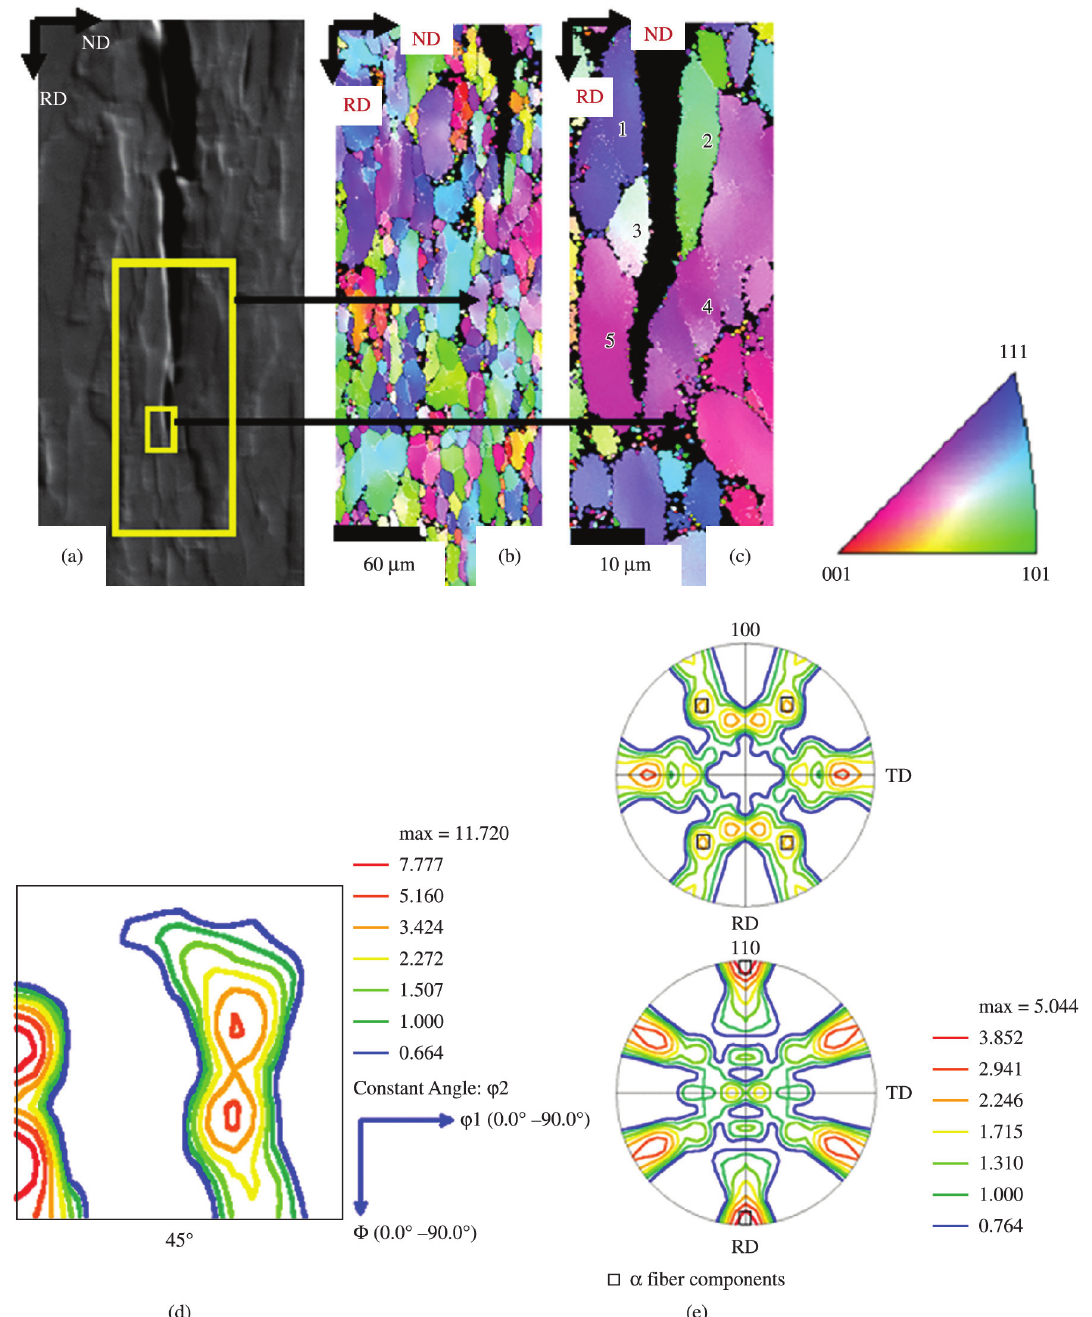
Figure 14. Microtexture from the vicinity delamination region: a) analyzed region by EBSD; b) and c) orientation distribution map; d) orientation distribution function; and e) pole